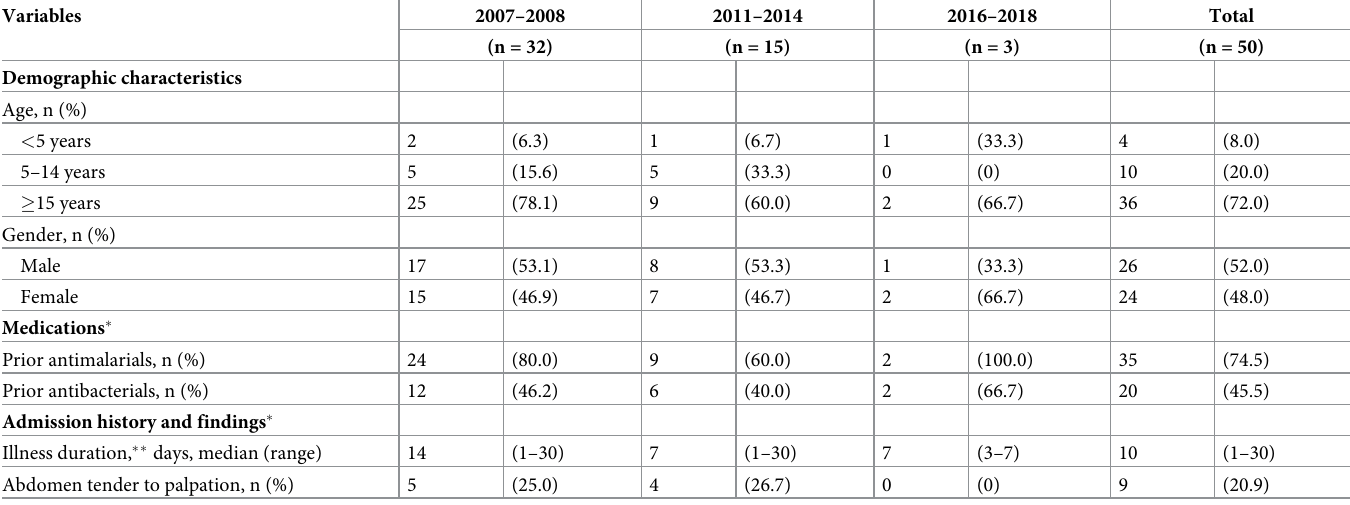
Table 2. Demographic and clinical characteristics of typhoid fever cases, Kilimanjaro Region, Tanzania,